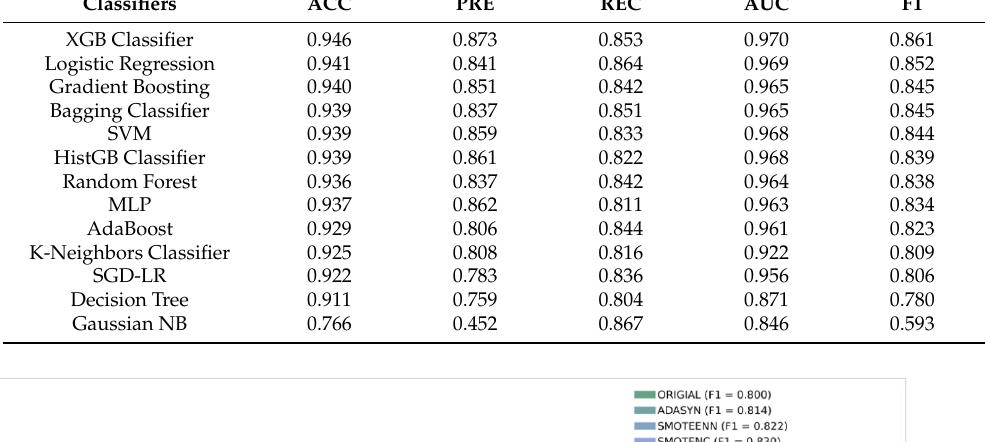
Table 5. Performance evaluation of 13 classifiers with K-means SMOTE.